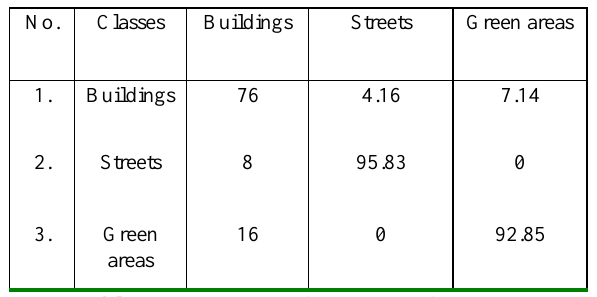
Table 11 . Producer’s accuracy for the image from 2021